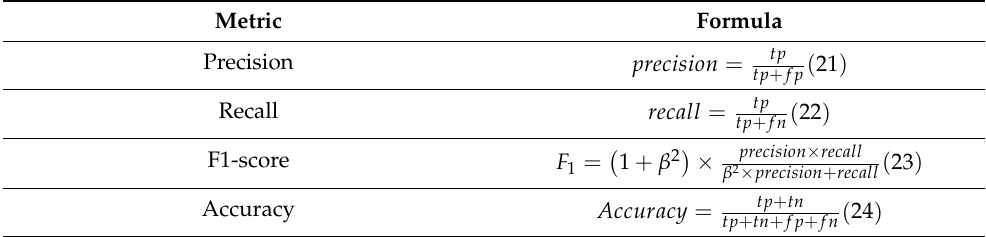
Table 8. Evaluation metrics in classification report.